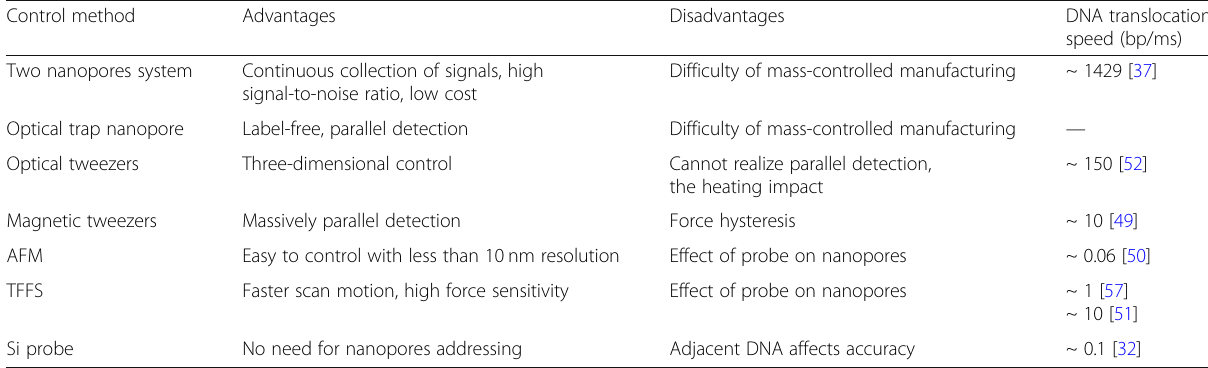
Table 1 DNA translocation speed with some DNA control method Control